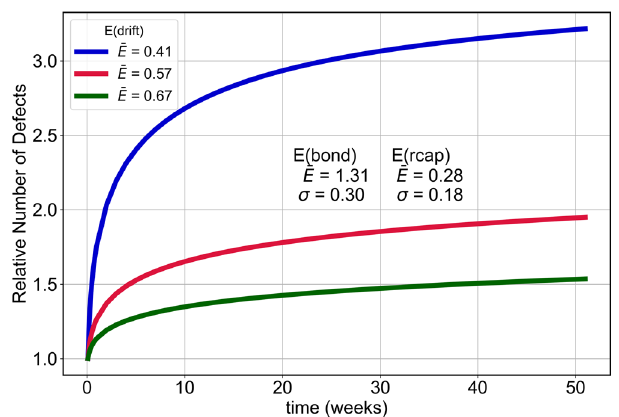
Fig. 6 Defect growth over time with different μ H ( z ) gradients. SolDeg- simulated results of the interface defect density N ( t ) with mean values of E μ z ) gradient pointing away from the interface — blue; H ( Drift representing a or a reversed gradient pointing towards the interface: moderate gradient — red, stronger gradient — green, comparable to the magnitude of the original gradient (blue). The defect density N ( t ) at 1 year was suppressed by 80% in reversed gradient NoDeg